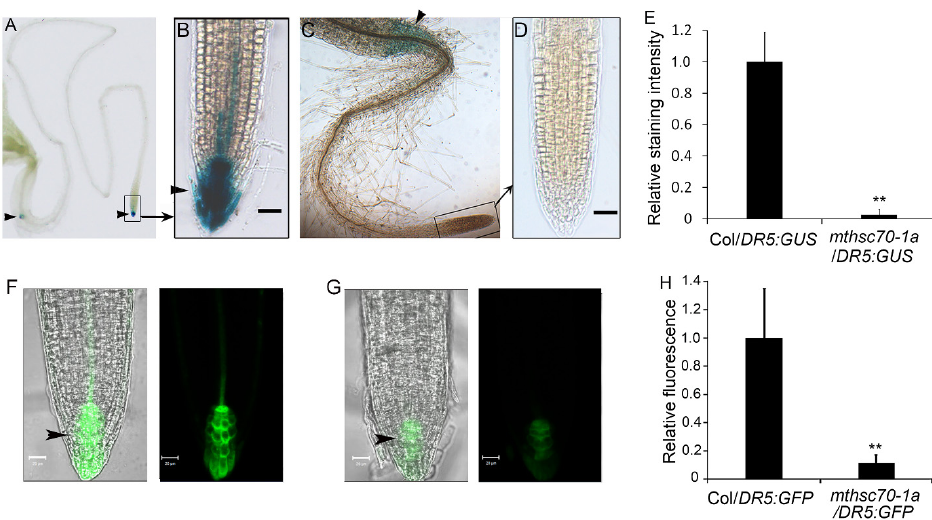
Figure 2. mtHSC70-1 knockout decreased the meristem length and mitosis activity in root tips. ( A ) The cell files of primary root tips by FM4-64 staining. The roots of 5 days old seedlings were observed using a LSCM. Representative images are shown. The cells without obvious elongation in the stele area were used as the standard of meristem cells in this experiment. The zones between two white dotted lines were measured. ( B ) Meristem lengths of the primary root tips. The data are the means ± SD of 30 roots. The experiments were repeated three times with similar results. The asterisks indicate significant differences from WT ( t- test, **, p < 0.01). ( C ) Results of S-phase entry of primary root tips by EdU staining. The roots of 6 days old seedlings were observed using a LSCM. Representative images are shown. Top row, EdU staining; bottom row, merge of EdU fluorescence and bright field. WT, wild-type; mthsc70-1a , a mtHSC70-1 mutant line; R2, a complementary mthsc70-1a line. Scale bar = 20 μ m.